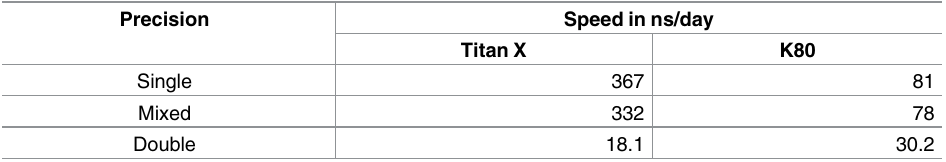
Table 4. Effect of precision model on